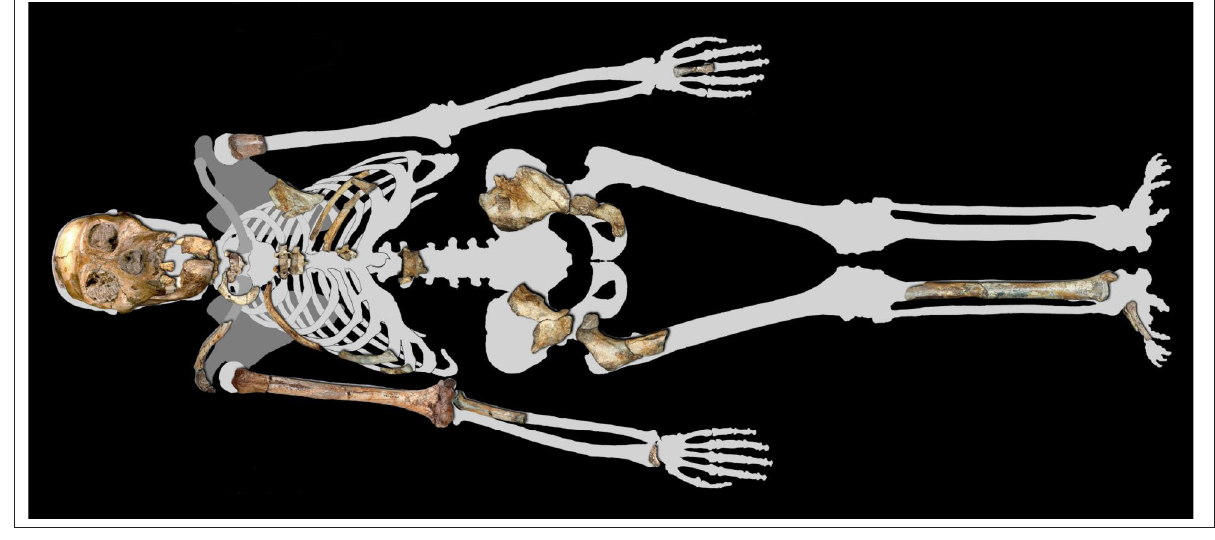
Figure 1: Surviving skeletal elements attributed to Malapa Hominin 1 (at time of